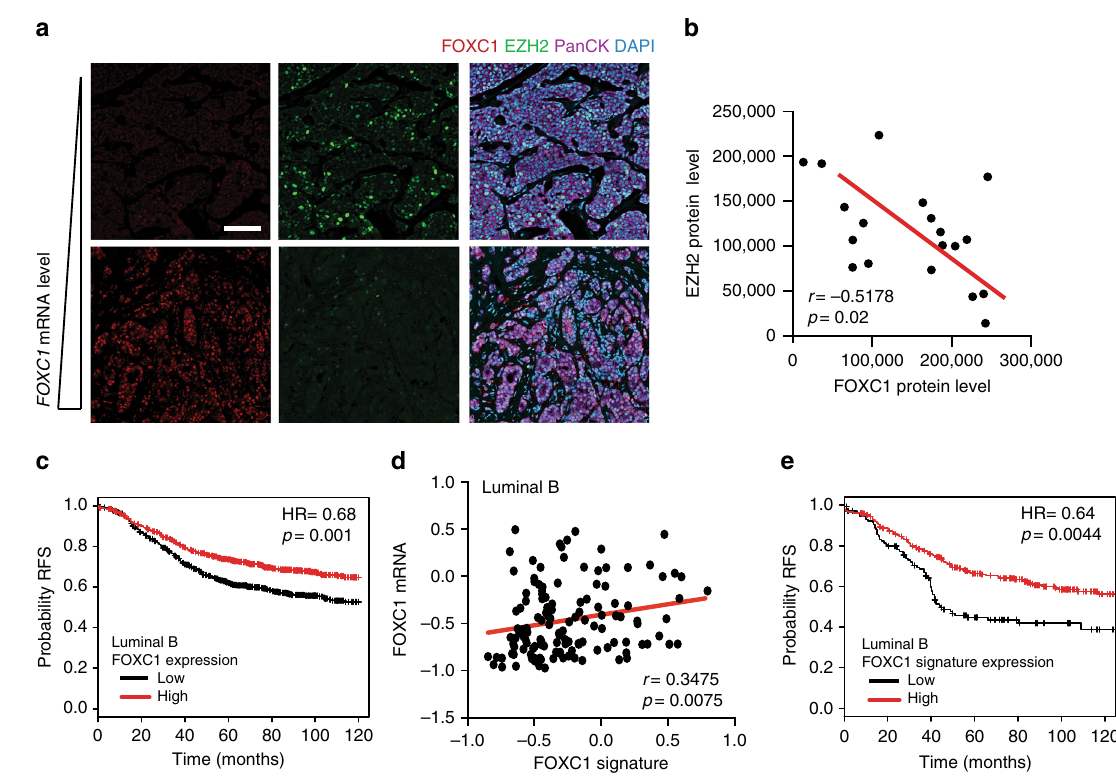
Fig. 6 Breast Cancer subtype speci fi city of the EZH2/FOXC1 metastatic axis. a Representative images of formalin fi xed paraf fi n-embedded tissue samples from human Luminal B tumours stained for FOXC1 and EZH2. Scale bar is 100 μ m. b Signi fi cant negative correlation between FOXC1 transcript levels and EZH2 protein levels (Total intensity) quanti fi ed by immuno fl uorescence in human Luminal B patient samples ( r = − 0.52, p = 0.02). Eight different fi elds taken with a ×20 objective were quanti fi ed per sample. c Kaplan – Meier survival curve of relapse-free survival (RFS) of 1142 luminal B tumours with high or low FOXC1 (log rank p = 0.001). d Correlation between FOXC1 mRNA levels and the FOXC1 Signature in a cohort of 385 Luminal B patients from